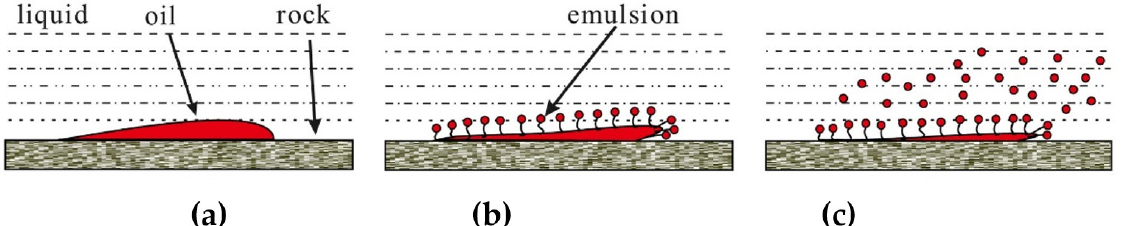
Figure 4. The formation of O/W emulsions by the shearing mechanism.